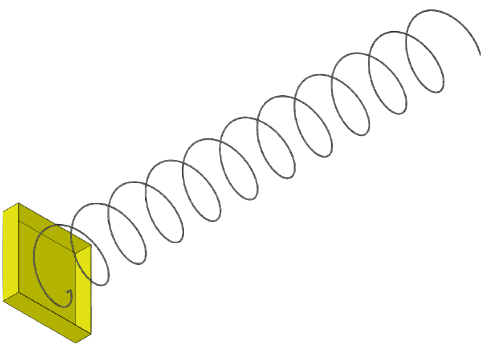
Figure 9. Model with cubic cup ground plane.